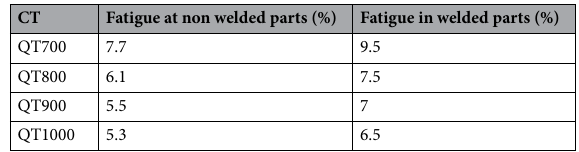
Table 17. Fatigue damage from the nitrogen shooting job.